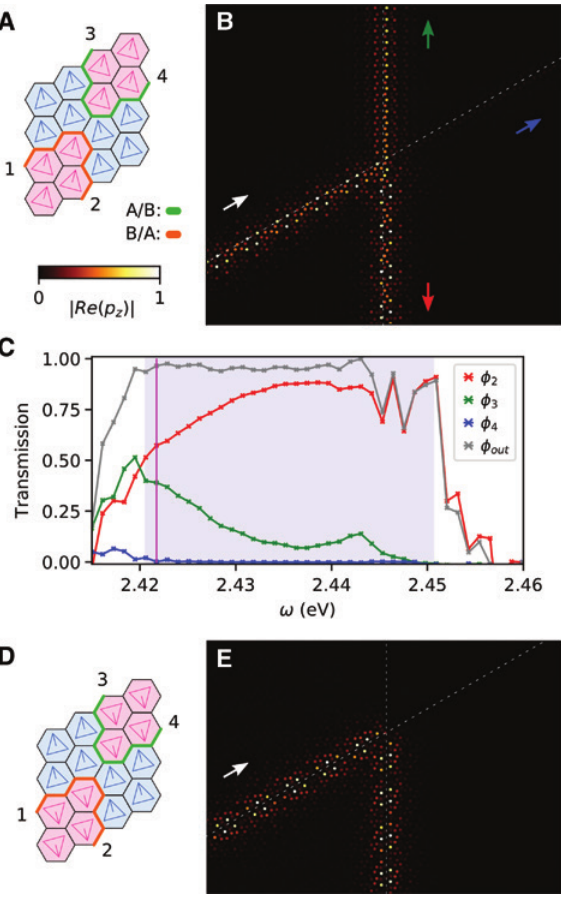
networks. Figure 9: Dual-band waveguiding with C 6 v networks. (A) Diagram of the unit cells and two-way splitting junction. Figure 8: Topological waveguiding with C 3 v (A) Type I: two-way splitting junction. (B) ω = 2.421 eV. The mode (B) ω = 2.800 eV. The mode propagates around both gentle along lead 1 splits at the junction, propagating around the gentle and sharp bends, with almost zero propagation along lead 4. 2 π /3 (lead 3) and sharp π /3 (lead 2) bends. (C) Transmission φ along (C) ω = 2.446 eV. The mode also propagates and splits at lower each lead. The band gap is highlighted in blue. (D) Type II: filtering frequencies. (D) Transmission φ along each lead over the junction. (E) ω = 2.426 eV. The mode only propagates around the frequencies at which topological modes are excited for lower- and sharp π /3 bend, owing to there being no mode, at this frequency, higher-frequency bands. (E and F) Modes excited at the along the other interface to couple into.